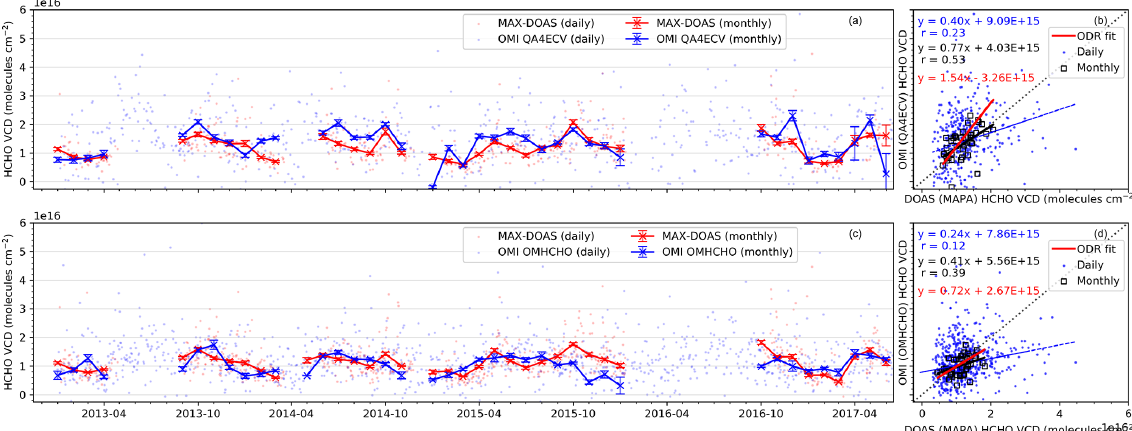
Figure 10. Intercomparison of time series of daily (dots) and monthly mean (lines and markers) HCHO VCDs retrieved from ground-based MAX-DOAS measurements and the OMI QA4ECV data product (a) and the OMI OMHCHO data product (c) . The respective vertical error bars represent the 1 σ monthly variability as the standard error of the mean. The monthly means of the MAX-DOAS and satellite data products were calculated by considering only the days of the month when both the measurements were available, causing different MAX-DOAS means in (a) and (c) . Scatter plots (b, d) using the daily and monthly mean values are shown adjacent to the time series.